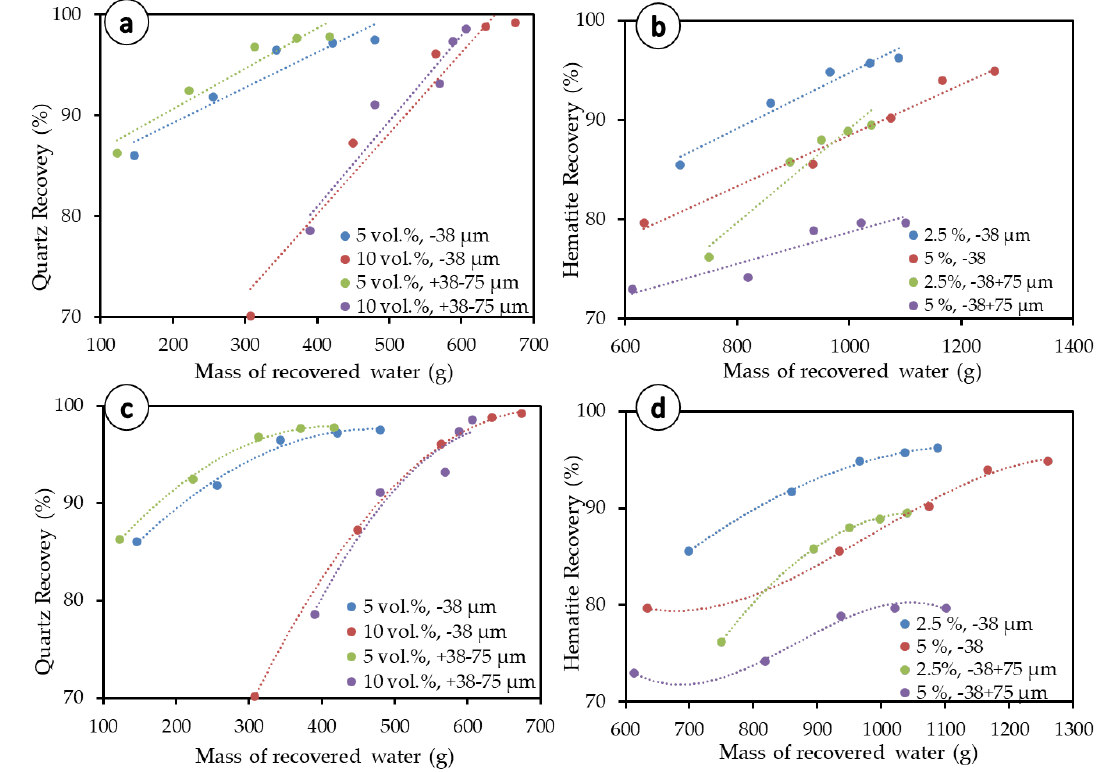
Figure 9. Equation fitting for mineral recovery. ( a ) Warren model applied to quartz, ( b ) Warren model applied to hematite, ( c ) polynomial fitting applied to quartz, and ( d ) Polynomial fitting applied to hematite. Table 4. Linear and polynomial fitting of entrainment.